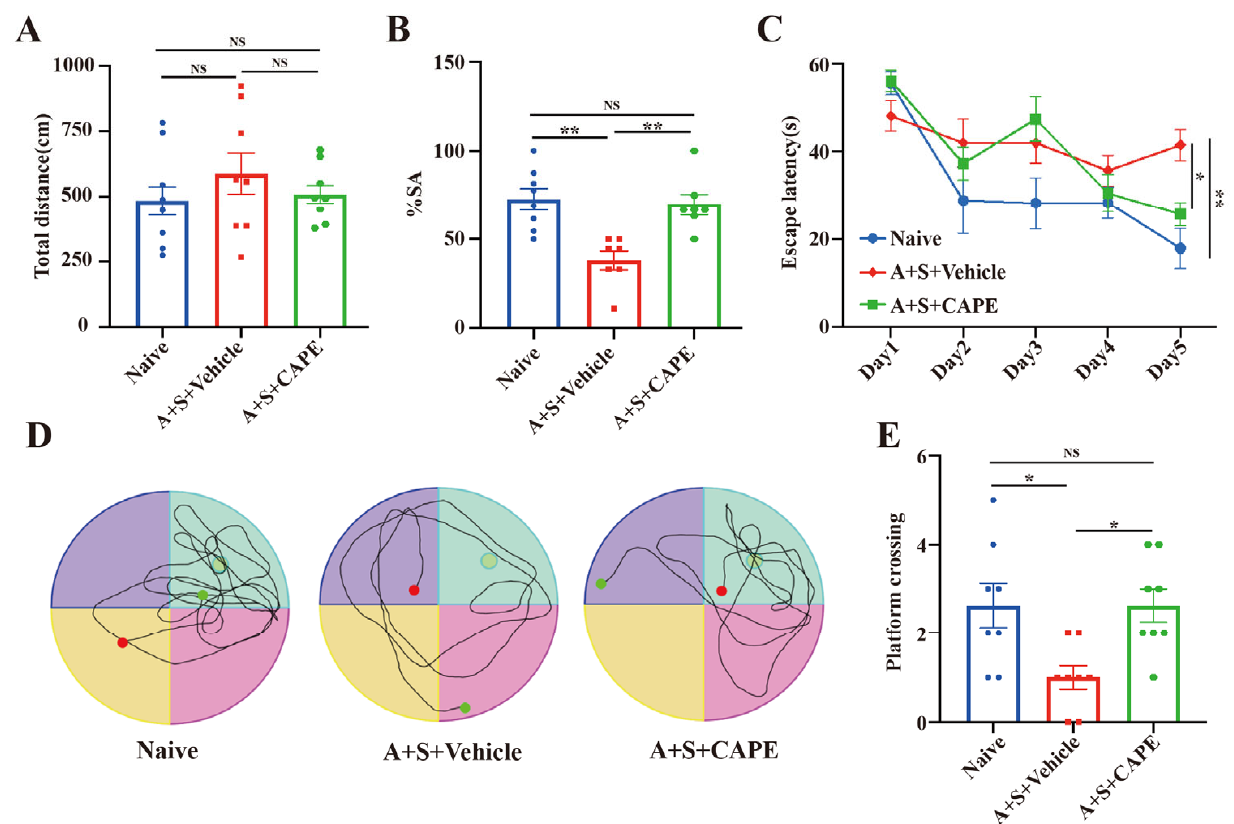
Figure 2. CAPE pretreatment ameliorates cognitive dysfunction following anesthesia and surgery in aged mice. ( A ) Total distance traveled in the OFT (one-way ANOVA, p value = 0.5207; n = 8 per group). ( B ) The percentage of spontaneous alternation in the YMT (one-way ANOVA, p value = 0.0007; Naive group n = 8, A + S + Vehicle group n = 7, A + S + CAPE group, n = 7). ( C ) Escape latency in fi ve consecutive training days of the MWMT (two-way repeated measures ANOVA, time: p < 0.0001, groups: p value = 0.0460; interaction: p value = 0.0051; n = 8 per group). ( D ) Representative trace graphs on the fi fth day of training in the MWMT. ( E ) Platform crossing in the probe trial of the MWMT (Kruskal–Wallis non-parametric test, p value = 0.0123; n = 8 per group). (* p < 0.05; ** p < 0.01; NS regarded as not signi fi cant).